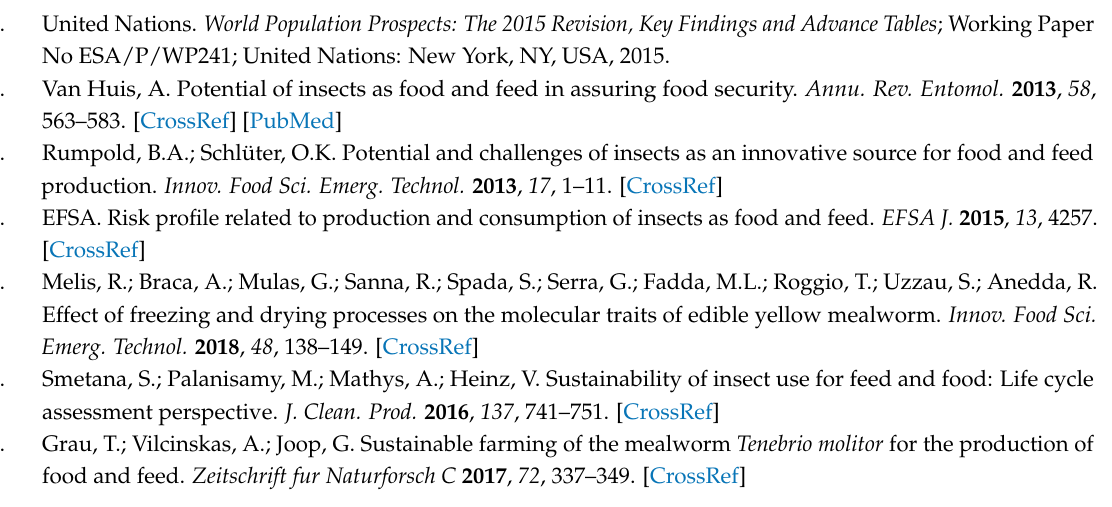
Figure S1: Fatty acid spectrum of processed, Figure S2: GC-chromatograms form wheat bran (A) and Tenebrio molitor Larvae (B), Table S1: Tabular representation of Headspace GC-analysis of dried Tenebrio molitor